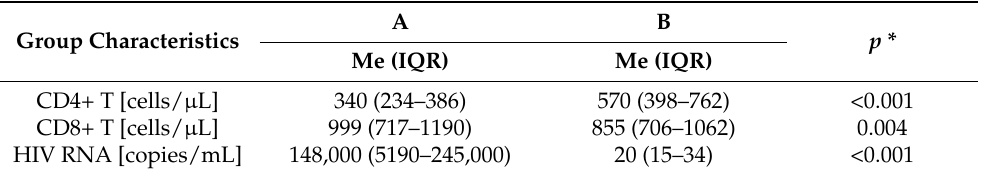
Table 2. Immunological data of HIV-infected men groups before (A) and after cART (B) with statistical analysis. Group